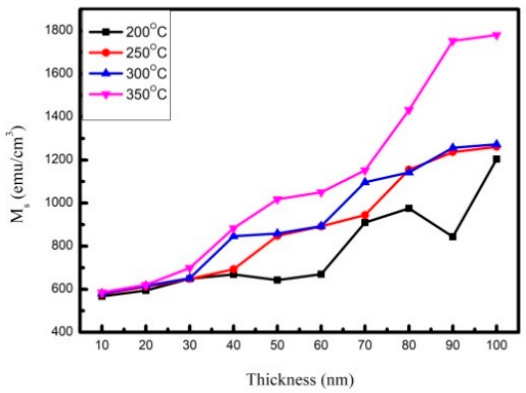
Figure 4. Saturation magnetization (M S ) of CoFeWB thin films. Figure 5a–d show the low-frequency alternating-current magnetic susceptibility ( χ ac ) result of CoFeWB films with thicknesses ranging from 10 to 100 nm under four conditions.